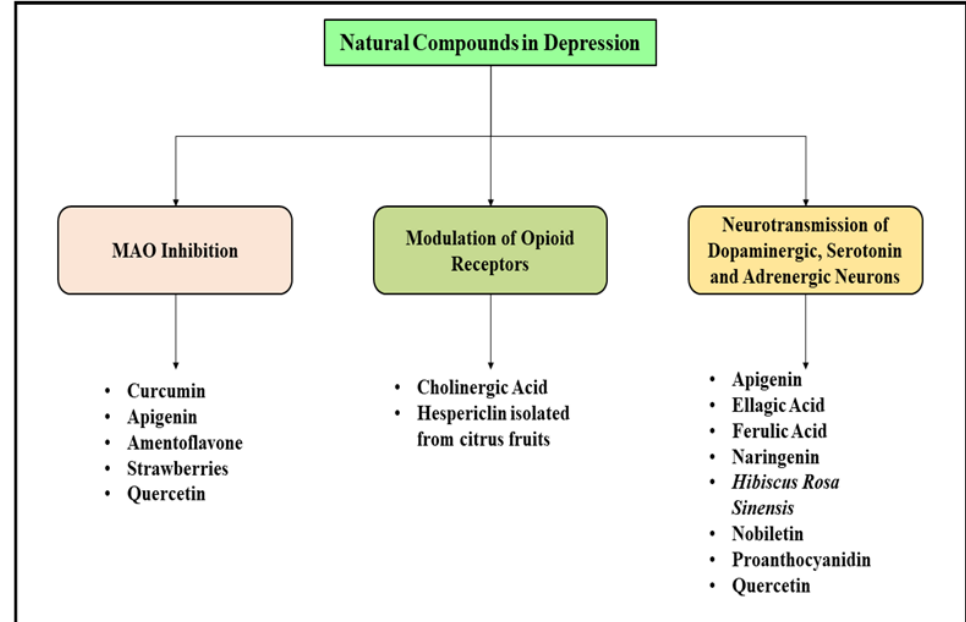
Figure 4. Pathological factors responsible for the initiation and prolongation of depression and list of herbal plants and bioactive natural origin molecules with anti-depressant effects.